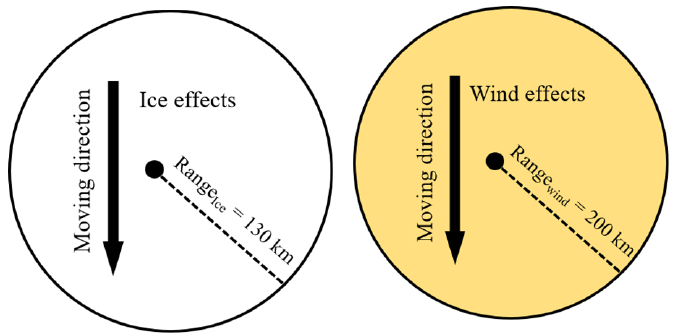
Figure 15. Ice effects range and Wind effects range.